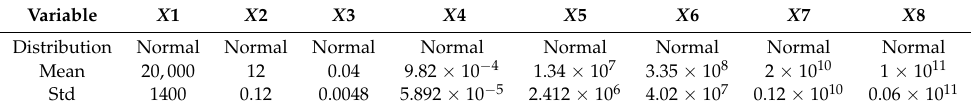
Table 4. Variables for the non-linear model.